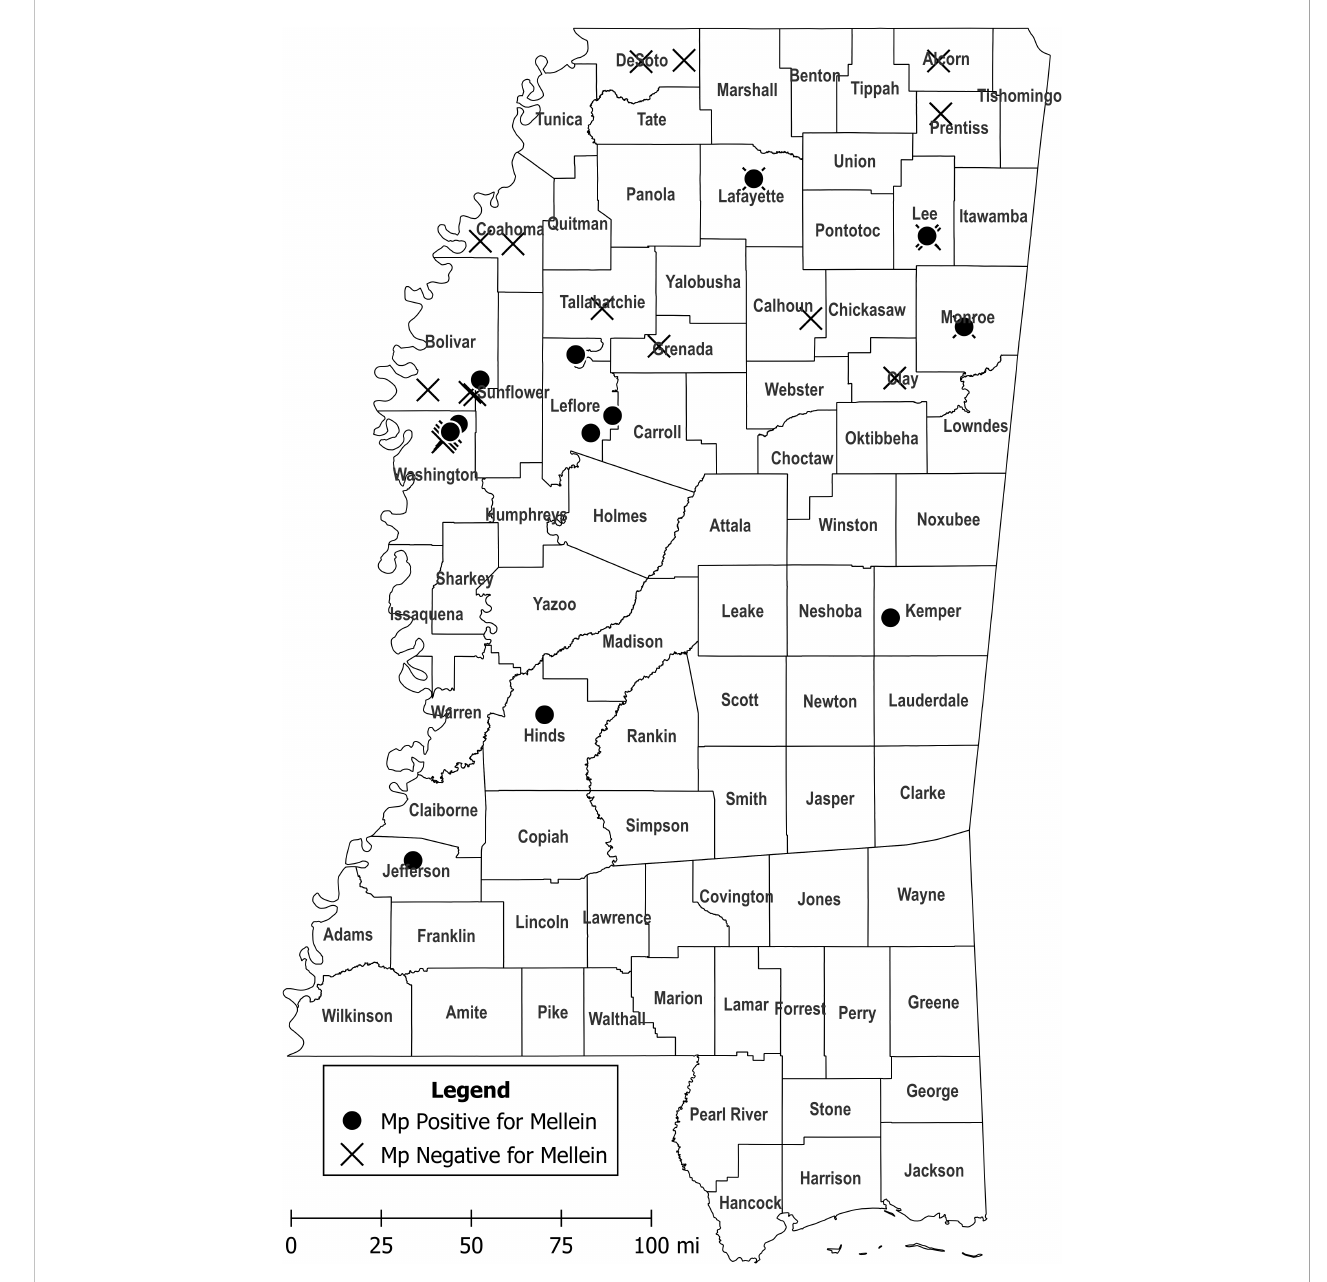
FIGURE 3 Collection sites of M. phaseolina isolates in Mississippi that produced mellein in culture at levels detectable by LC-MS/MS (circles) and collection sites of M. phaseolina isolates that did not produce detectable mellein (crosshatches). M. phaseolina isolates were also collected from Illinois, Louisiana, Oklahoma, and Tennessee (not shown), but none of them produced mellein in culture. Map fi gure was created using QGIS, an open-source geographic information system application, and cartographic boundary fi les available on the US Census Bureau